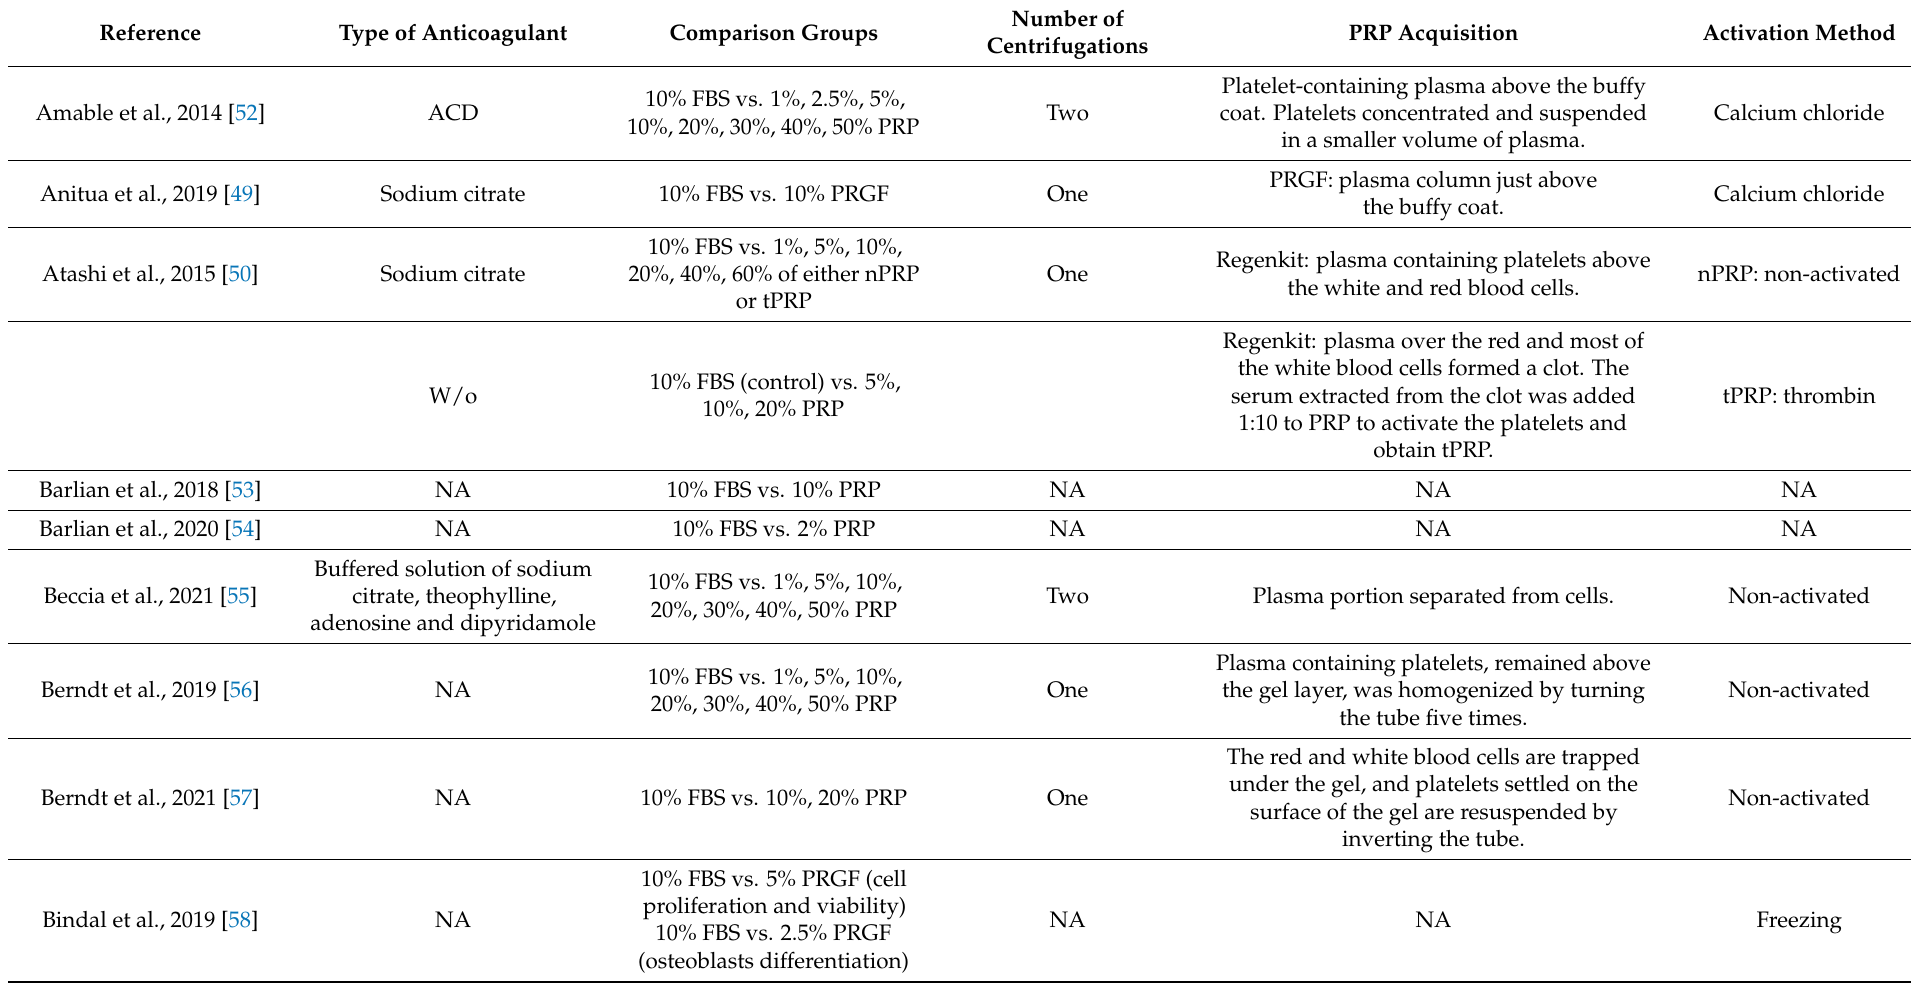
Table 2. Description of the PRP acquisition process in the reviewed articles.